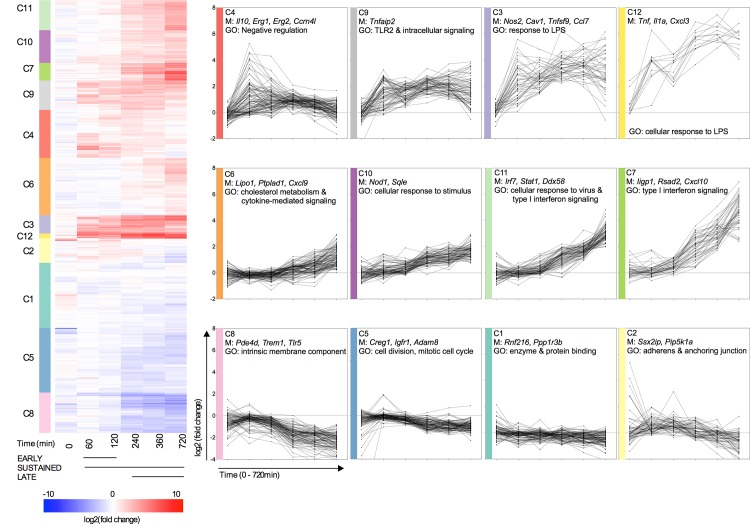
Intracellular Helicobacter pylori induces temporal waves in macrophage immunity.Clustering analysis was performed on differentially expressed genes (FDR p-value <0.05) obtained from RNAseq performed on macrophages co-cultured with H. pylori. Values are presented as the log2 (ratio) of average infected (n = 3) to average non-infected (n = 3) for each time point (0, 60, 120, 240, 360 and 720 min post-co-culture). Transcripts were grouped into 12 gene-modules based on expression levels and temporal behavior. Gene expression profiles for each cluster are plotted with representative members (M) and similarities in function identified by Gene Ontology (GO).